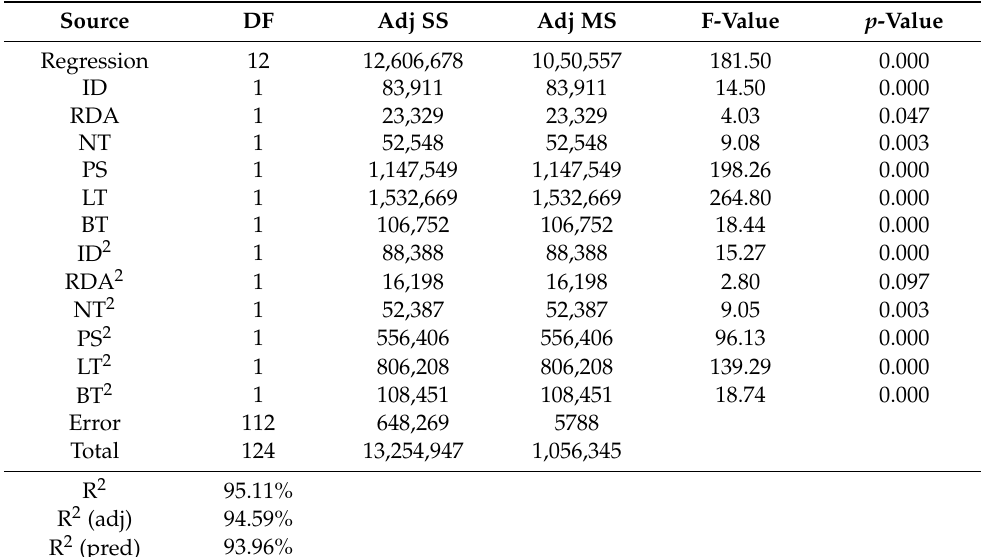
Table 4. Polynomial ANOVA, printing time vs. ID, RDA, NT, PS, LT, BT. Source